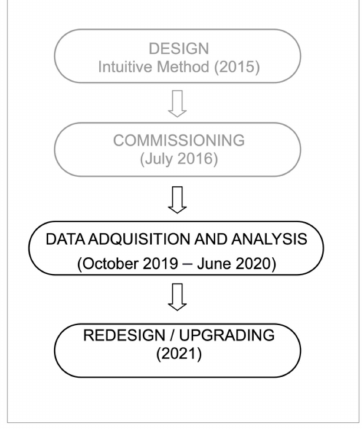
Figure 1. Flow chart of research